Question: Looking at the figure, what chart type is it?
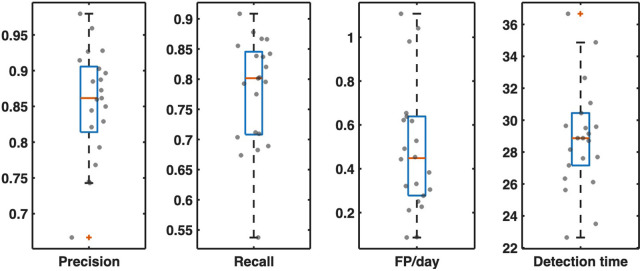
Answer: box